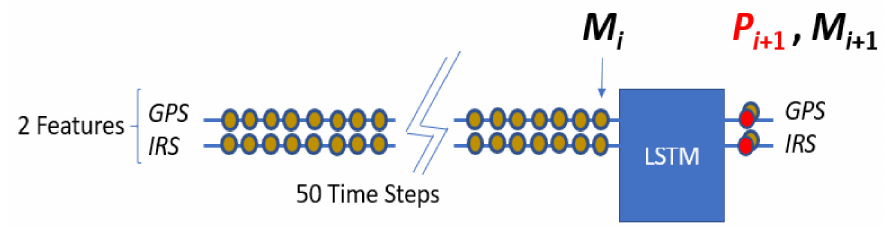
Figure 16. Predictive model for the X coordinate (real